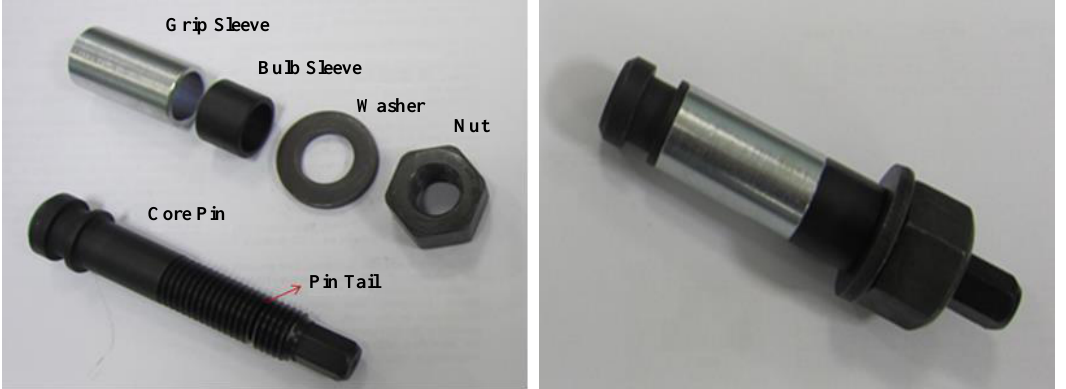
Figure 3. Fastening process of the blind bolt.